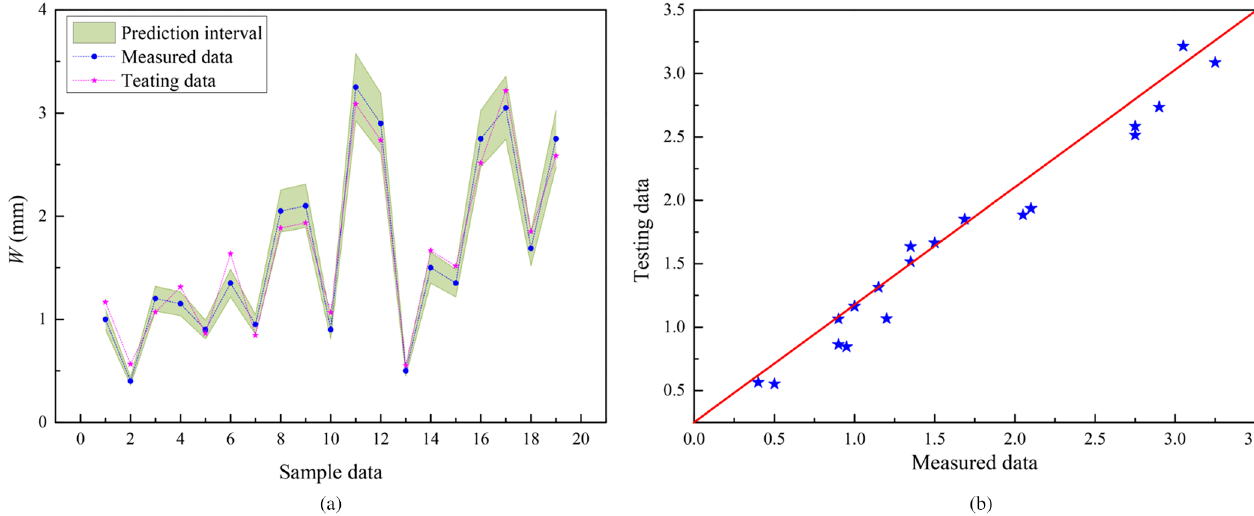
Fig. 6. The SVR testing results of cylinder liner wear. (a) Comparison of testing and measured data on the testing set. (b) Performance of SVR on the testing set.